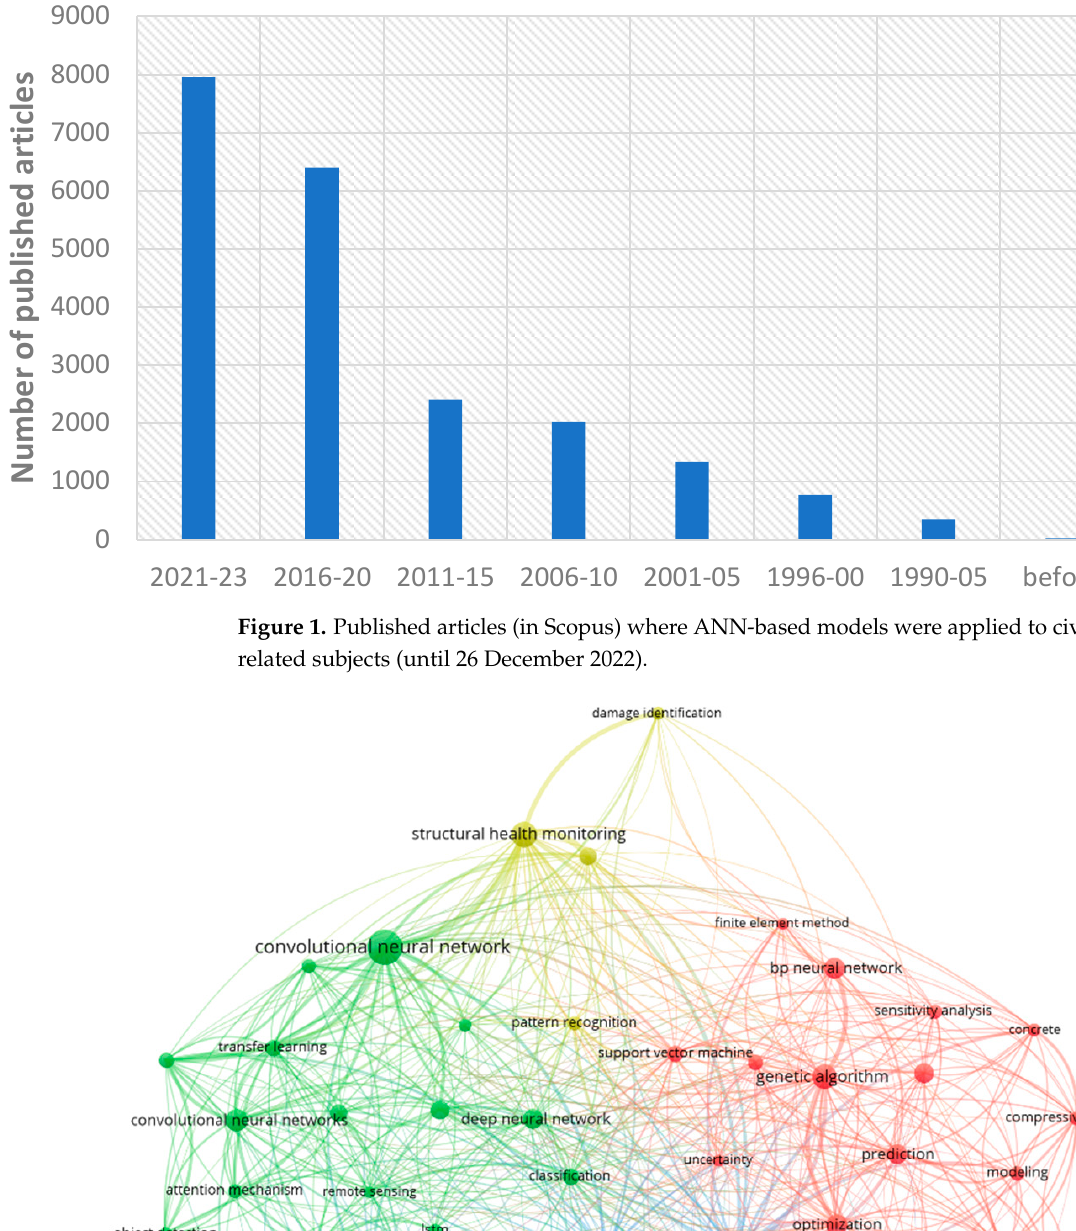
Table 1. The authors with most journal articles related to “Artificial neural networks applied in civil engineering”, in Scopus (until 26 December 2022). Author